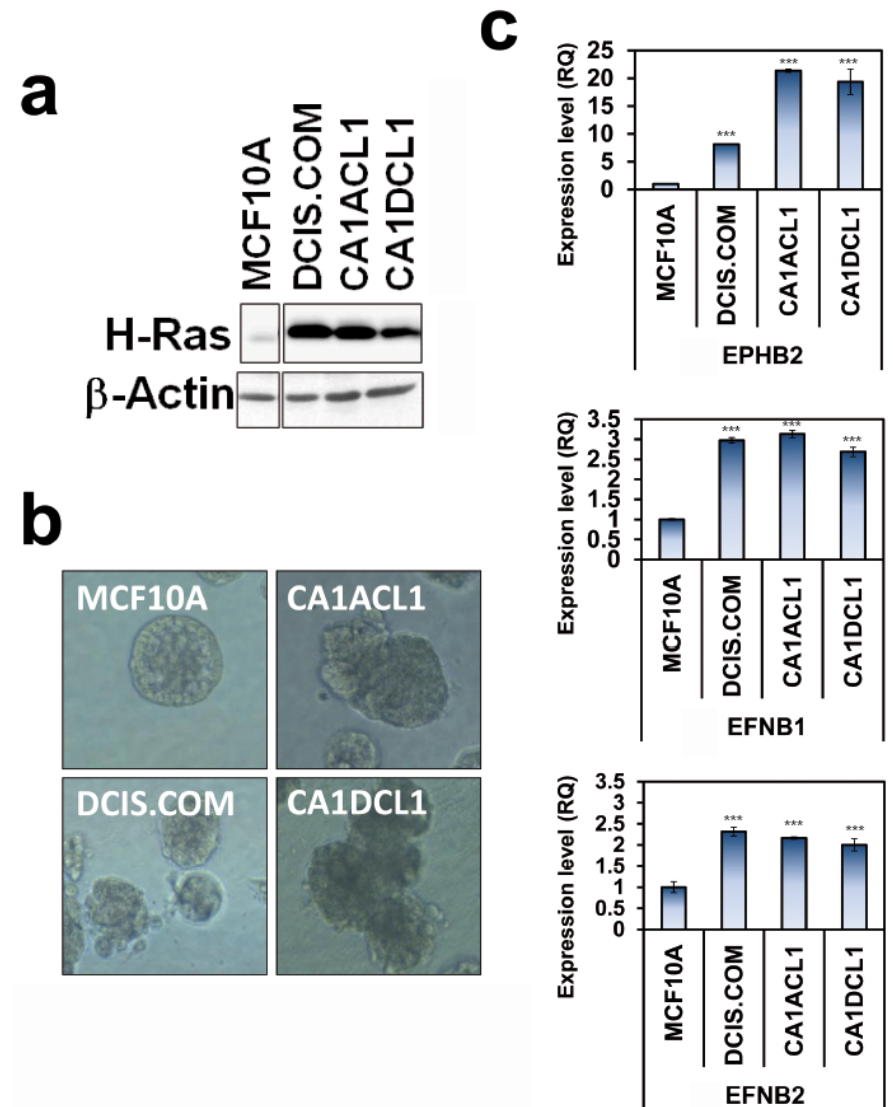
Figure 5. Expression of EphB2 and ligands EFNB1 and EFNB2 in an MCF10A-derived cellular model of breast cancer progression. ( a ) An immunoblot of H-Ras-transformed MCF10A-derived cells. ( b ) Phase contrast and immuno-fluorescence images illustrating the morphologies of normal MCF10A, derived DCIS.com, and invasive CA1acl1 and CA1dcl1 grown in 3D (Nuclear blue staining: DAPI, membrane green staining: β 4 integrin). After 10 days of culturing, MCF10A cells form polarized spherical acini that have hollow lumens. Transformed cell lines form complex, non-polarized, and dense masses. Magnification: 40×. ( c ) Real-time RT-PCR of expression of EphB2 and ligands in MCF10A-derived cells. RQ: Relative quantity. *** p < 0.005. t -test. GraphPad Prism5.